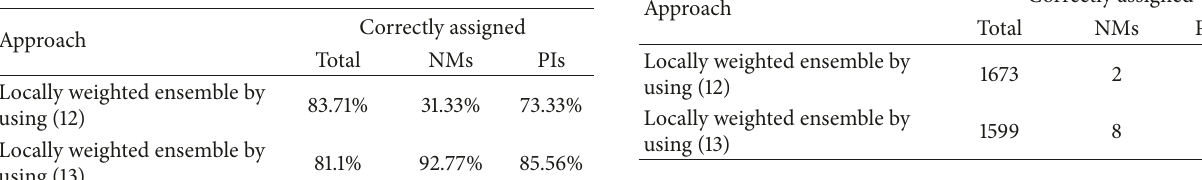
Table 8: Locally weighted ensemble percentage classification result using (12) and (13).